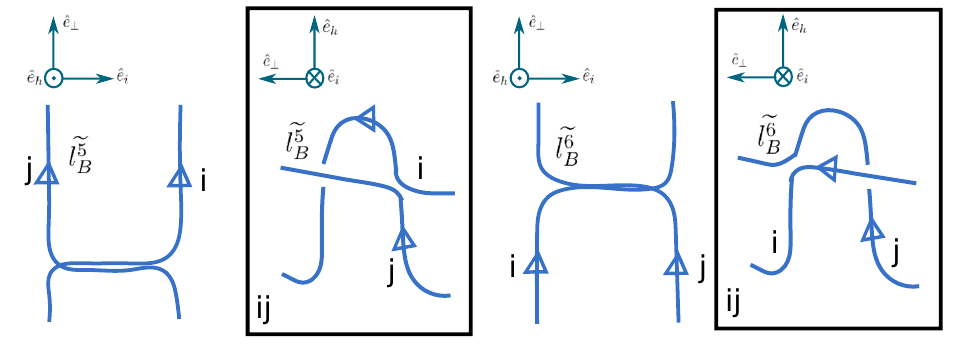
Figure 53 . Two lifts of l B whose contributions cancel each other.